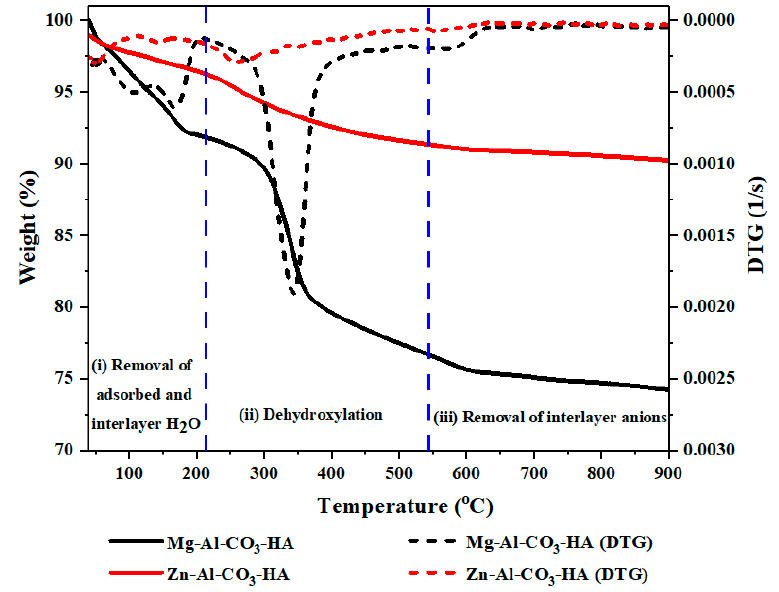
Figure 3. Thermogravimetric (TGA)/DTG analysis of Zn-Al-CO 3 -HA and Mg-Al-CO 3 -HA LDHs.